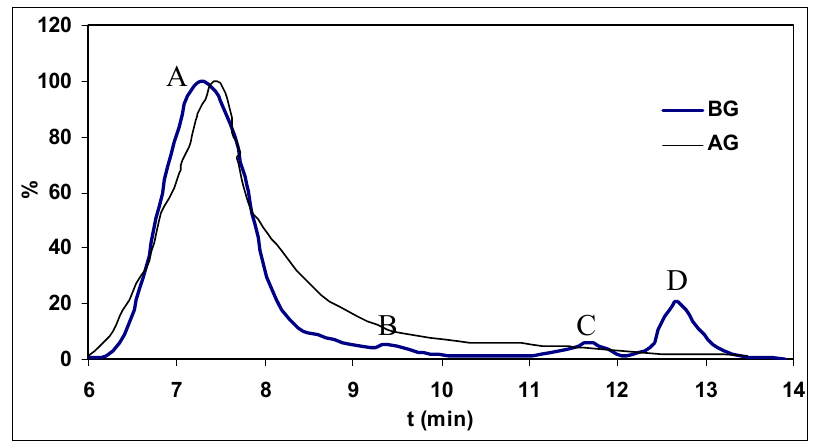
Figure 2. Chromatogram of BG and AG.